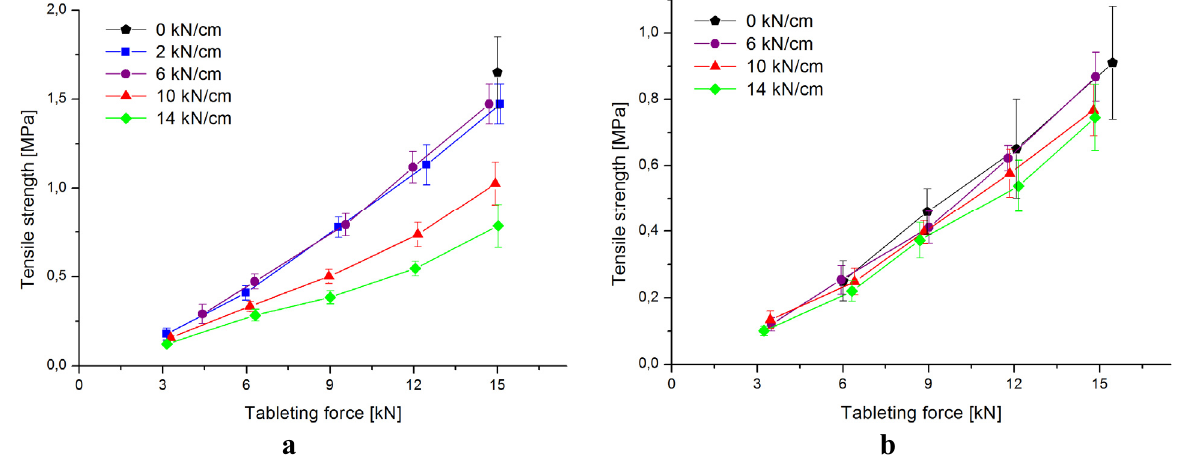
Figure 1. ( a ) Compactibility of isomalt tablets; ( b ) Compactibility of isomalt-DCP tablets. (mean ± SD, n = 10).